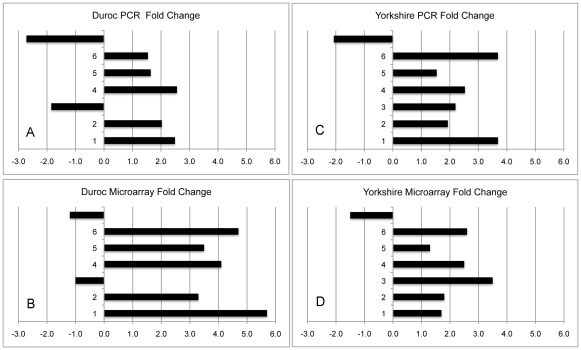
Comparison of PCR and microarray fold changes.Microarray fold changes were verified with qRT-PCR. The PCR fold changes for the genes listed in Table 1 in the Duroc breed (Panel A) are in substantial agreement with the microarray fold changes (Panel B). Similarly, the PCR fold changes in the Yorkshire breed (Panel C) demonstrate substantial agreement with the microarray fold changes (Panel D).